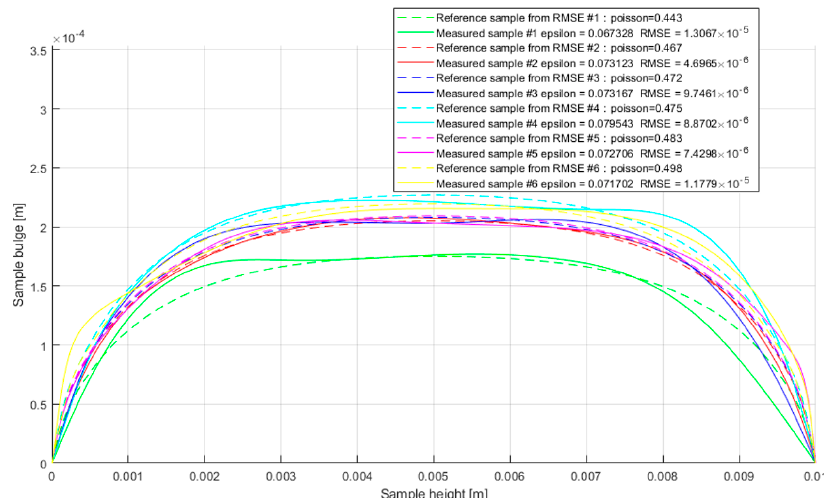
Figure 11. Set of results for Bulge shape fi tt ing using lowest RMSE fi t criterion.